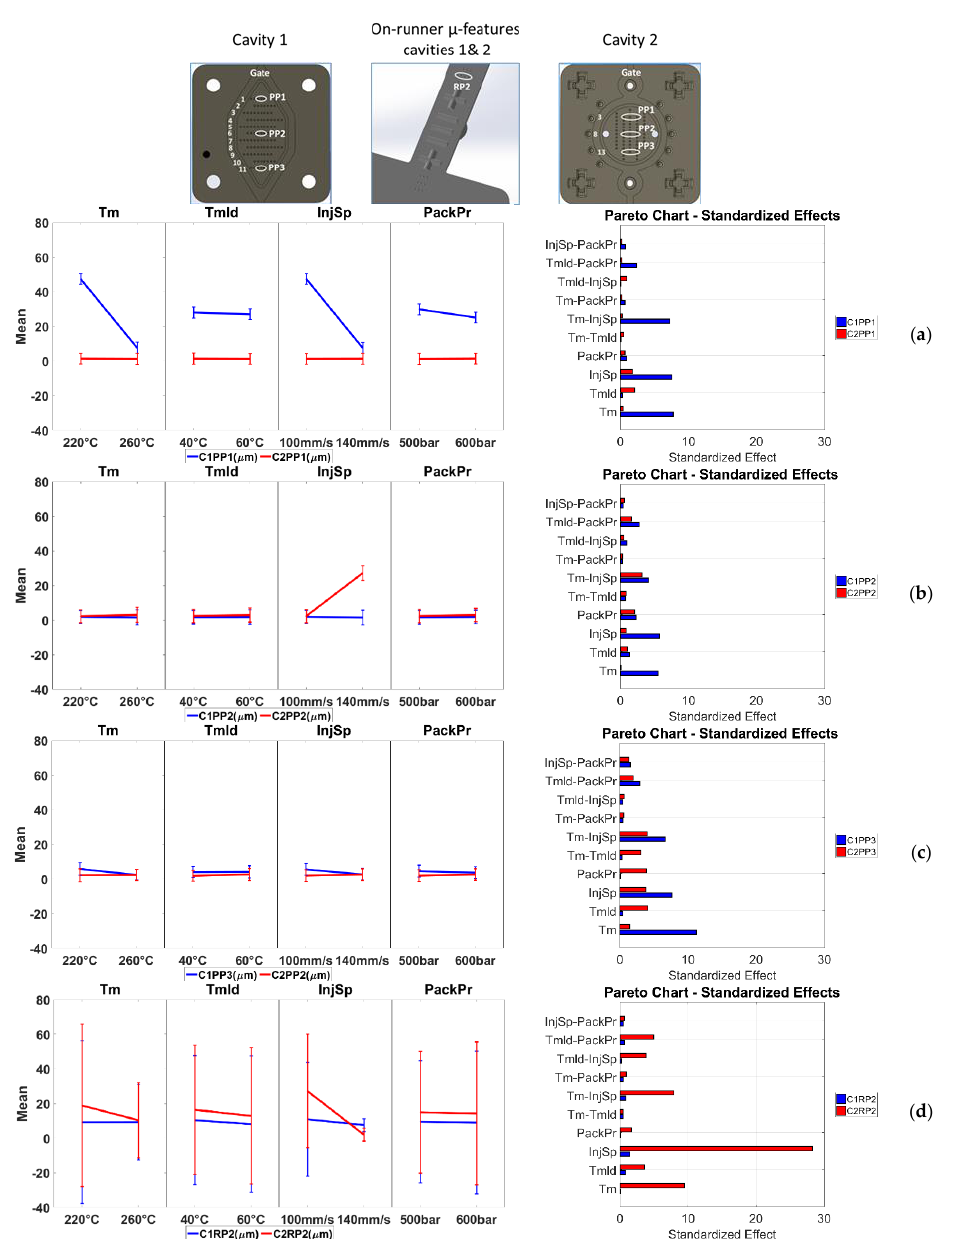
Figure 14 . Influence of IM process on the eight measurand deviations (from mold values) and “product fingerprints candidates”. ( a ) Position PP1 in Cavities 1 and 2, ( b ) position PP2 in Cavities 1 and 2, ( c ) position PP3 in Cavities 1 and 2, ( d ) position RP2 in Cavities 1 and 2. The figure presents the main effects (left column) and the Pareto graphs (right column), with a schematic representation of the measurement areas to be provided at the top. The error bars in the main effect’s plots represent the measurement uncertainty from the dataset of the respective product fingerprint (Table 6). In comparison to positions PP1, PP2, and PP3 that are located on the molded part, the μ-pillar features in positions RP2 (at the middle of the runner for both Cavities 1 and 2) (Figure 14d) are less